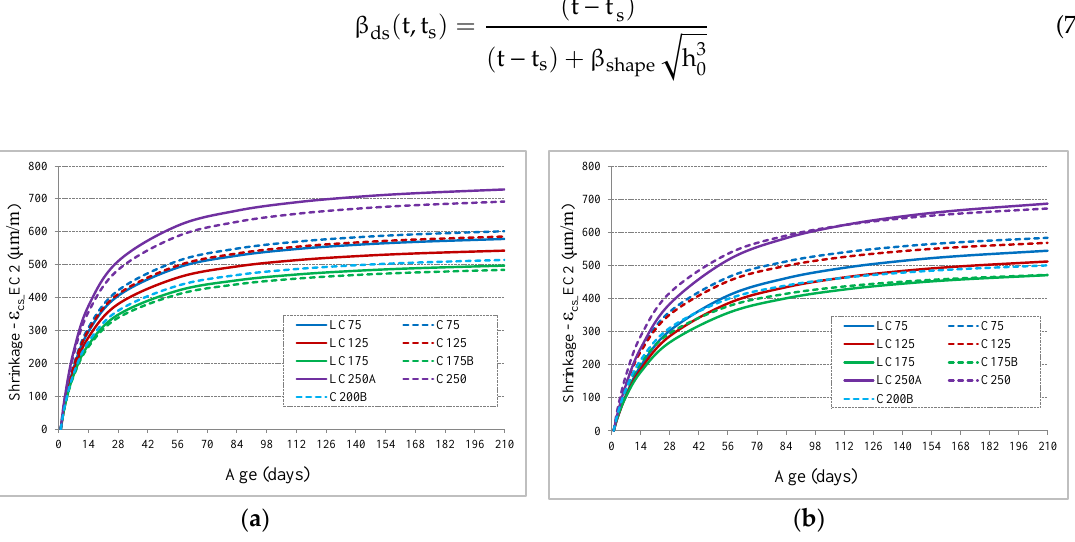
Figure 4. Comparison of the evolution of shrinkage by Eurocode 2 (EC2): ( a ) prediction curve with EC2 equations; ( b ) adaptation of the experimental evolution to prediction curve using the β shape coefficient.